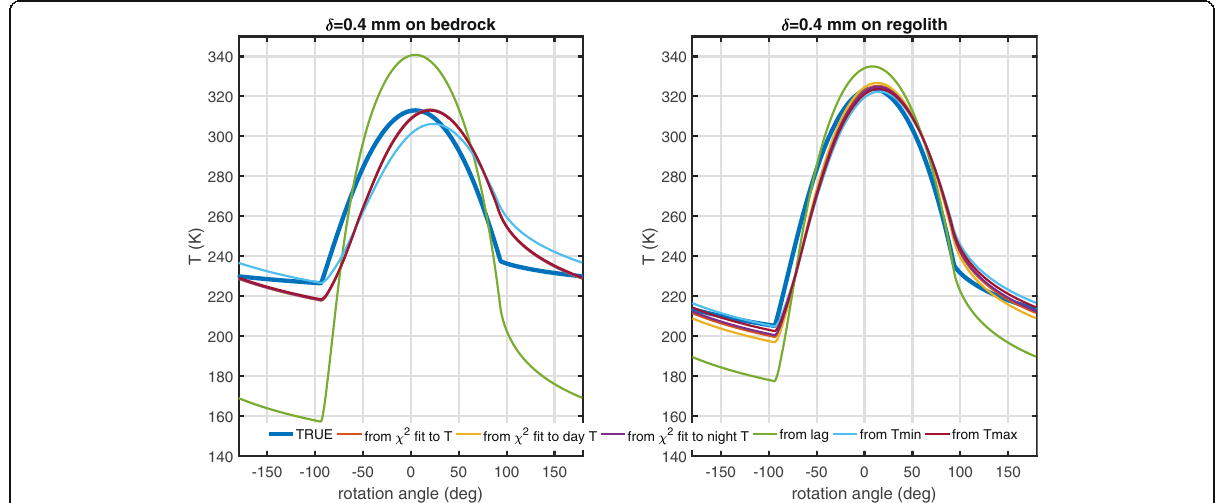
Fig. 5 Left: temperature as a function of rotation angle for the case of bedrock covered by a 0.4 mm dust layer (true, blue curve) along with 6 best-fitting models calculated under the assumption of a homogeneous one layer model. Right: same as top, but for dust-covered